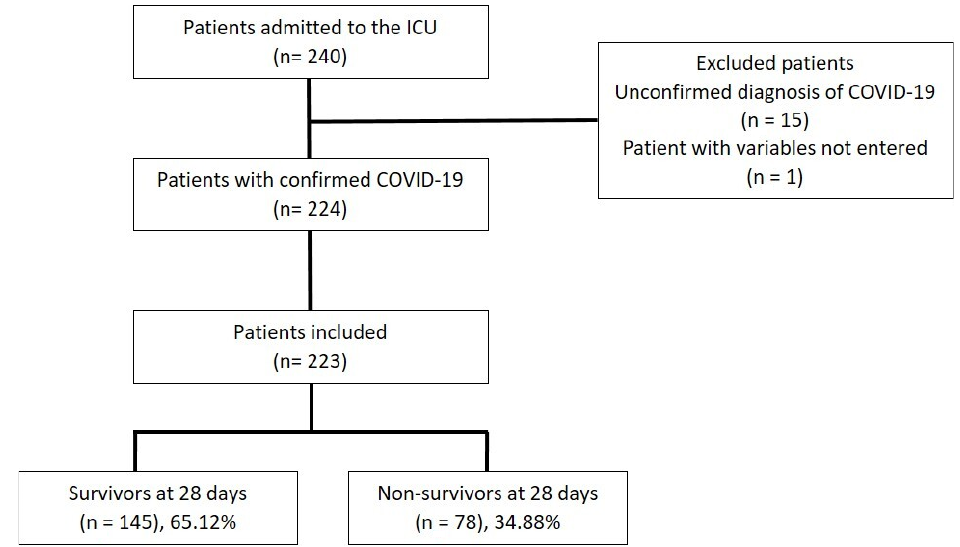
Figure 1. Flowchart of study inclusion and exclusion criteria. ICU: intensive care unit.